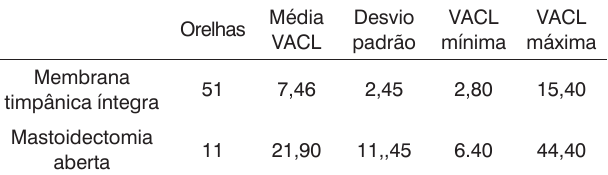
Tabela 3. Resultado das médias da VACL dos nistagmos da estimulação quente de todas as orelhas com membrana timpânica íntegra e de mastoidecomia aberta, excluindo os indivíduos com estimulação paradoxal.